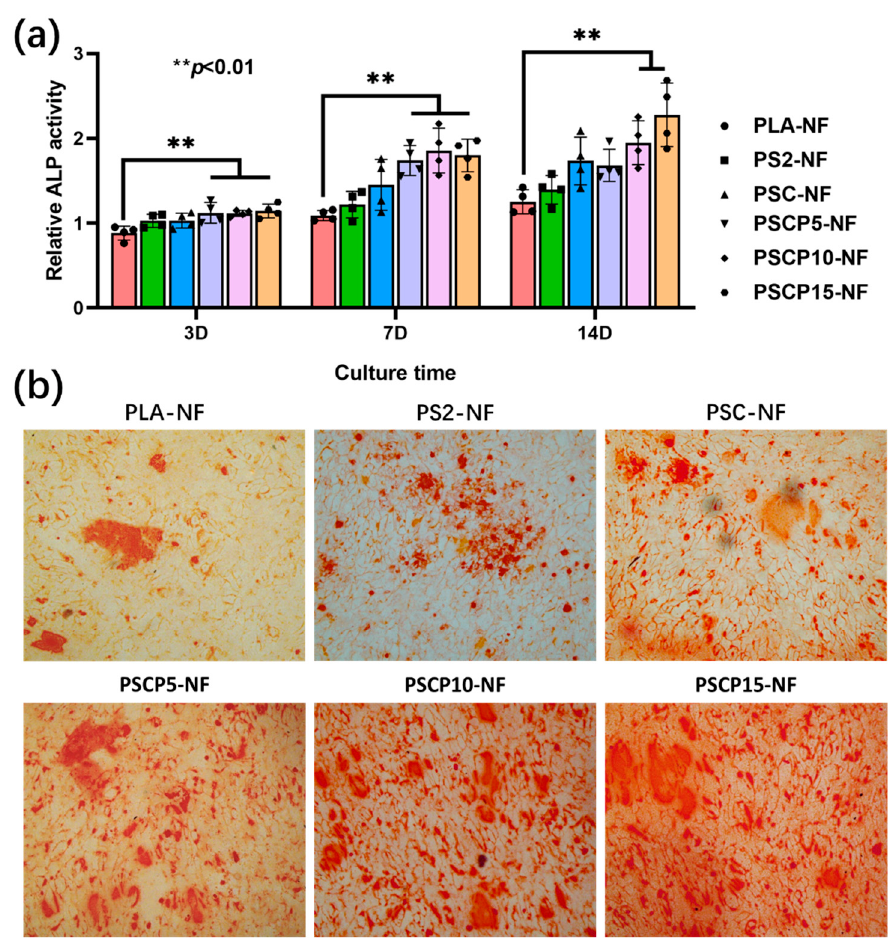
Figure 7. ( a ) ALP activity of BMSCs after incubating with various samples for different time points (signification difference compared to other groups ** p < 0.01); ( b ) digital photos of ARS-stained mineralized matrix on various samples after osteogenic incubation for 14 days.